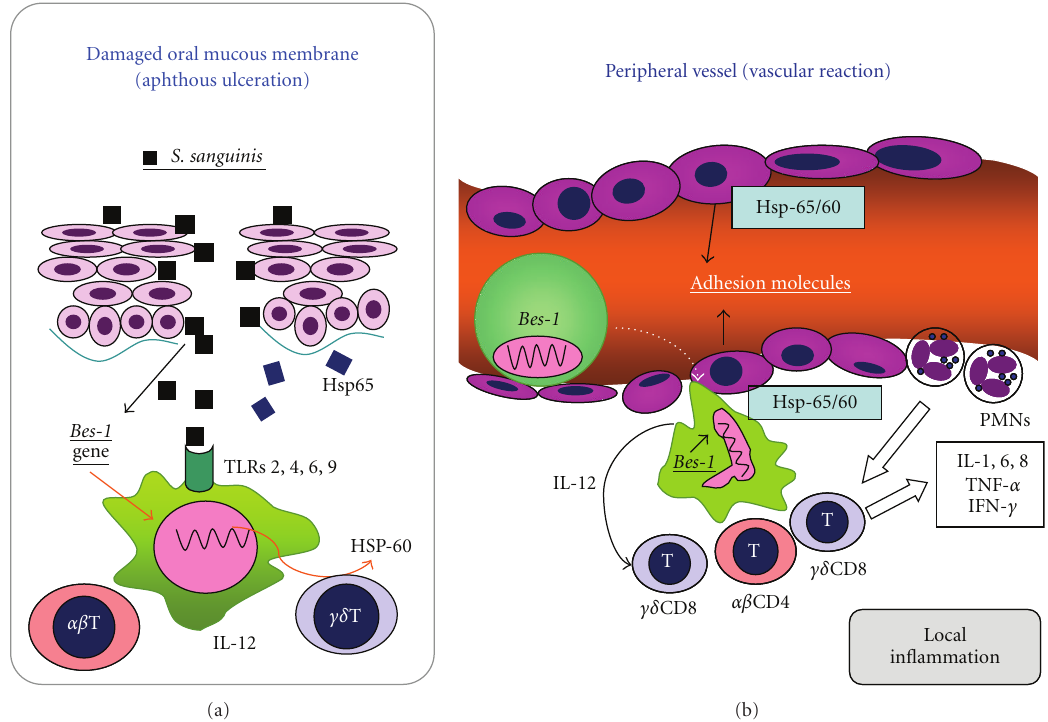
Figure 4: (a) and (b) Hypothesis of oral immune reaction developing the systemic manifestation in ABD. The local vascular reaction may be caused by the antigen presenting cells immunized by S. sanguinis in the oral cavity